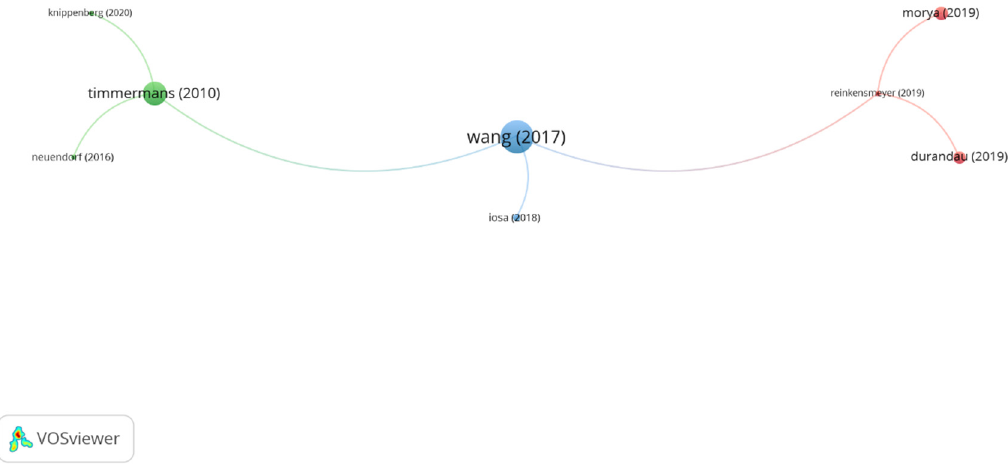
Figure 8. Group 5 citation network. The most cited publication is that of Timmermans (2010).